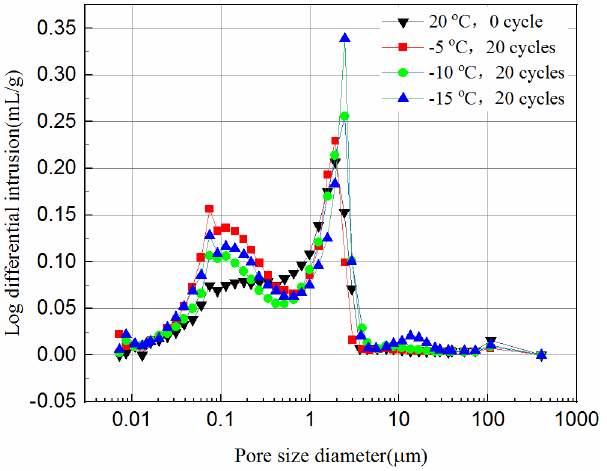
Figure 13. Log-differential pore volume curves of 28-day samples at different cooling temperature.